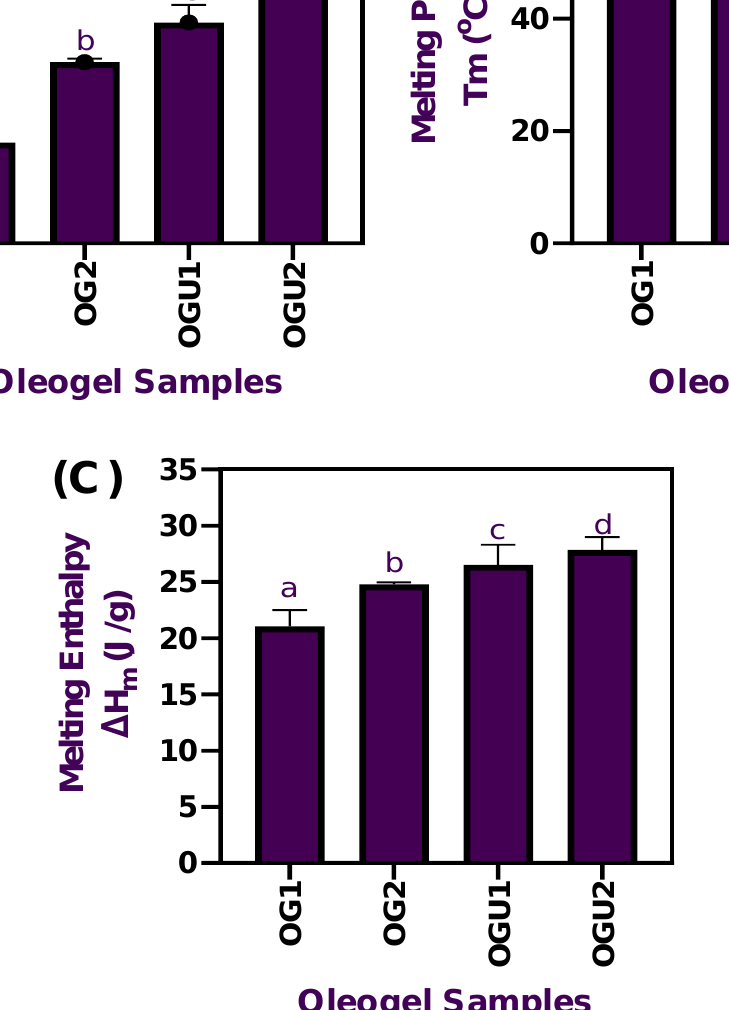
Figure 3. Melting onset ( A ), melting peak temperature ( B ), and melting enthalpy ( C ) of palm oil-based oleogels prepared with different concentrations of carnauba wax and the ultrasonication pro- cess.